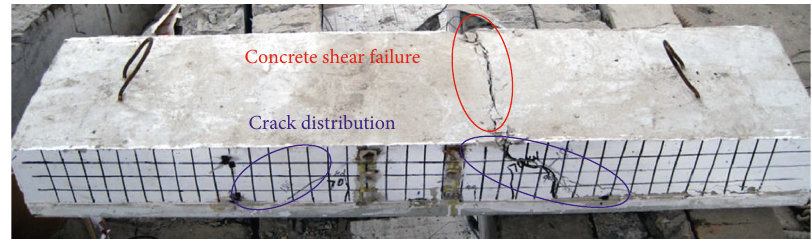
Figure 7: Specimen GC-3 cracks distribution and failure